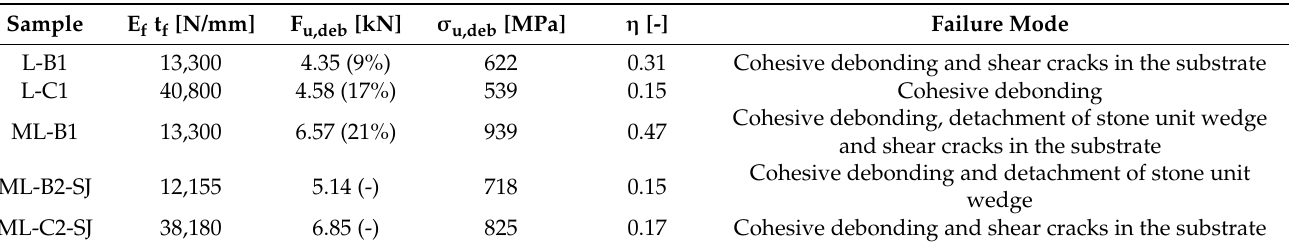
Table 6. Experimental results: stone unit and stone masonry unit—BFRP, CFRP1, and CFRP2 reinforcement [28].